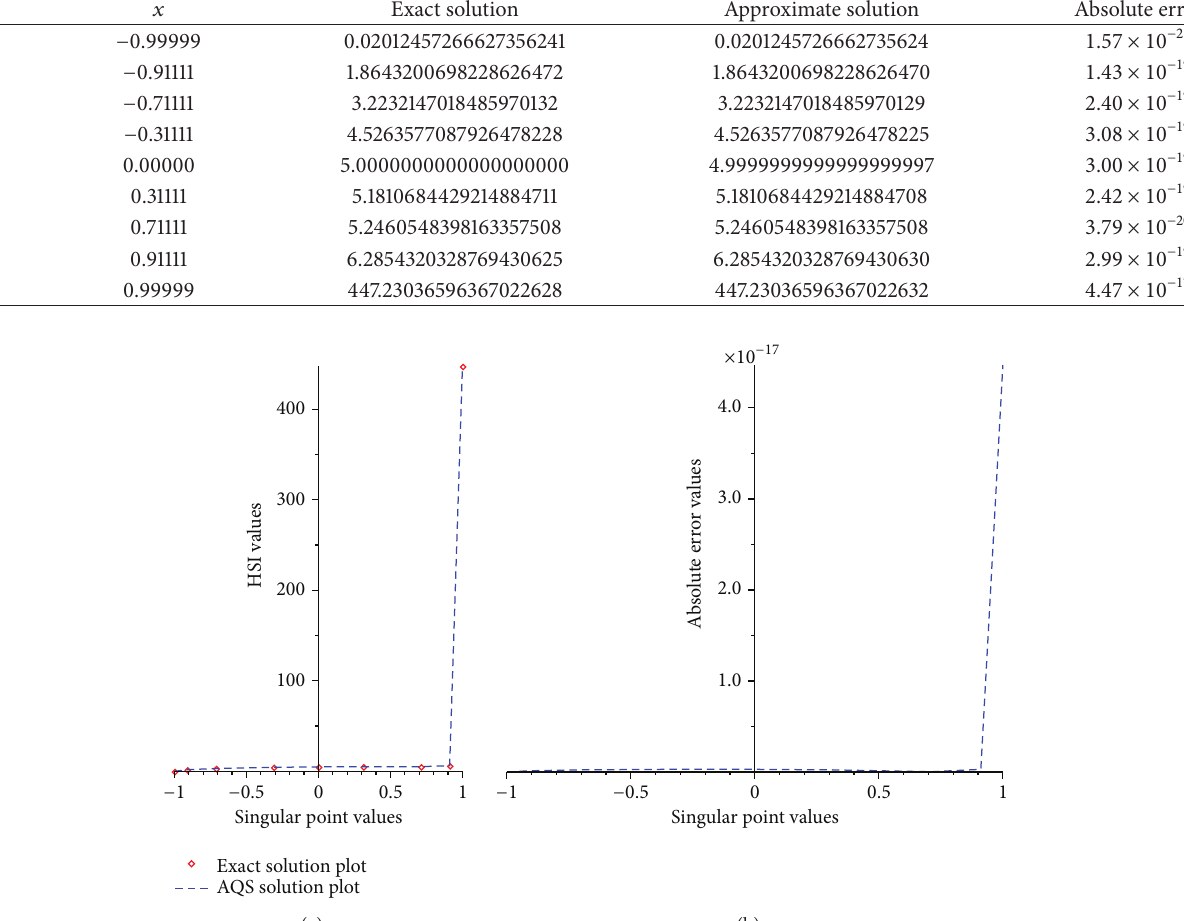
Table 2: Results of HSIs for 𝑤 2 (𝑡) .